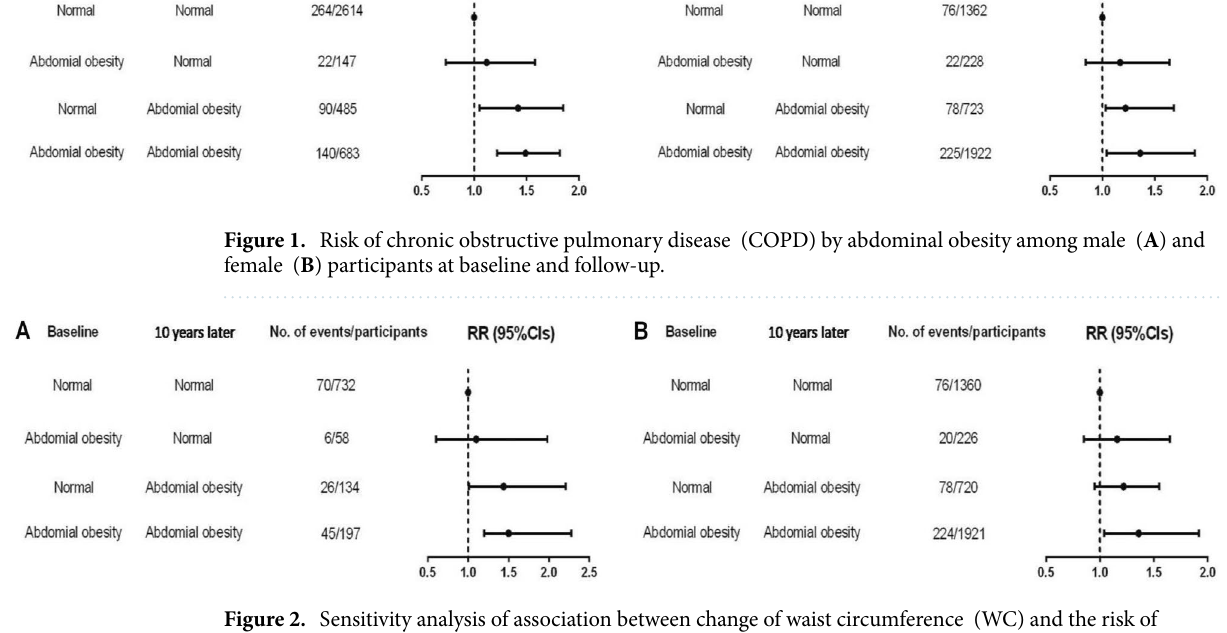
Figure 2. Sensitivity analysis of association between change of waist circumference (WC) and the risk of chronic obstructive pulmonary disease (COPD) among male ( A ) and female ( B ) participants who reported never